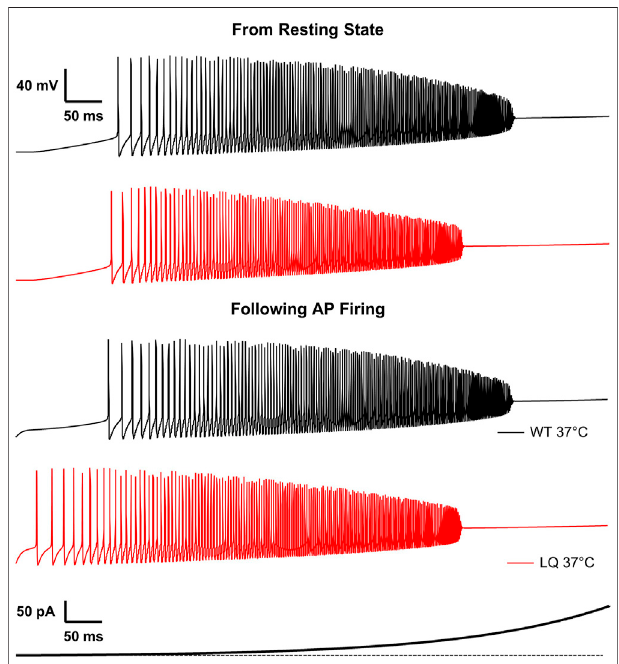
FIGURE 6 | L1624Q leads to depolarization block at lower input stimuli. Simulated action potential fi ring in WT (black) and L1624Q (red) expressing neurons at 37 ° Cin response toa slowly increasing stimulus current (bottom) . Simulations are conducted following a period of rest with zero stimulus (top) or following a10 ms pre-stimulusof 10 pA to induce AP fi ring (bottom) .